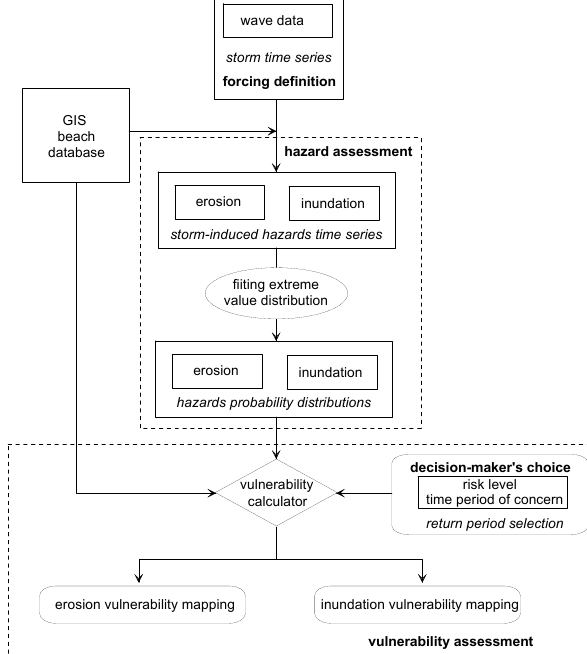
Fig. 2. Methodological framework for coastal vulnerability assess- ment to